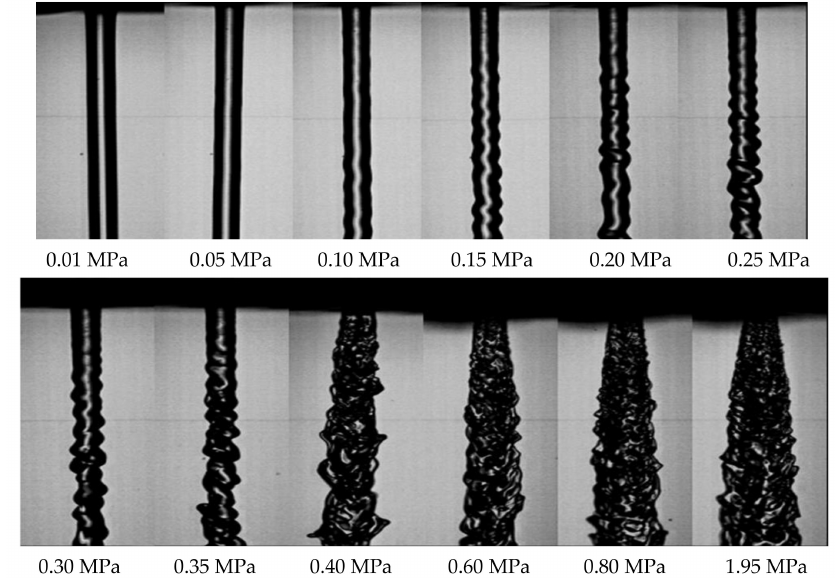
Figure 3. Vicinity characteristics of power law liquid cylindrical jet under di ff erent jet pressures (nozzle diameter 0.5 mm, 0.15 wt.% carbopol aqueous